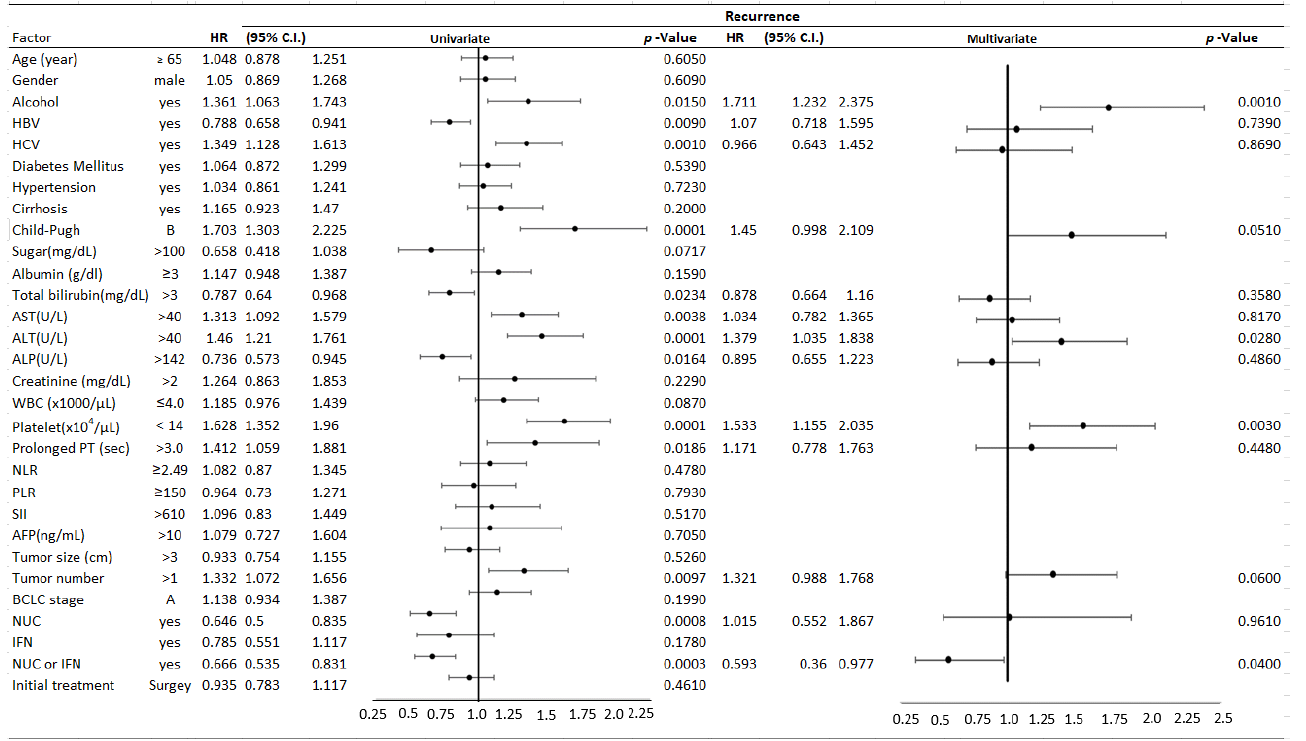
Figure 3. Univariate and multivariate stratified analyses for early-stage hepatocellular carcinoma (HCC), based on Barcelona Clinic Liver Cancer (BCLC) staging, with and without tumor recurrence after the initial curative treatment (forest plot). AFP, α -fetoprotein; ALP, Alkaline Phosphatase; ALT, alanine aminotransferase; AST, aspartate aminotransferase; CI, confidence interval; CBC, counts of blood cells; NLR, neutrophil to lymphocyte ratio; PLR, platelet to lymphocyte ratio; PT, prothrombin time; HBV, hepatitis B virus surface antigen; HCV, antibodies to hepatitis C virus; HR, hazard ratio; and SII, systemic immune-inflammation index.